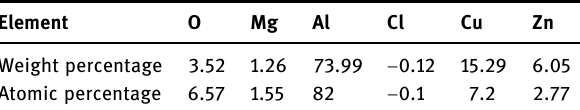
Table 7: Element analyses of corrosion products of the aluminium alloy ( % ) Element